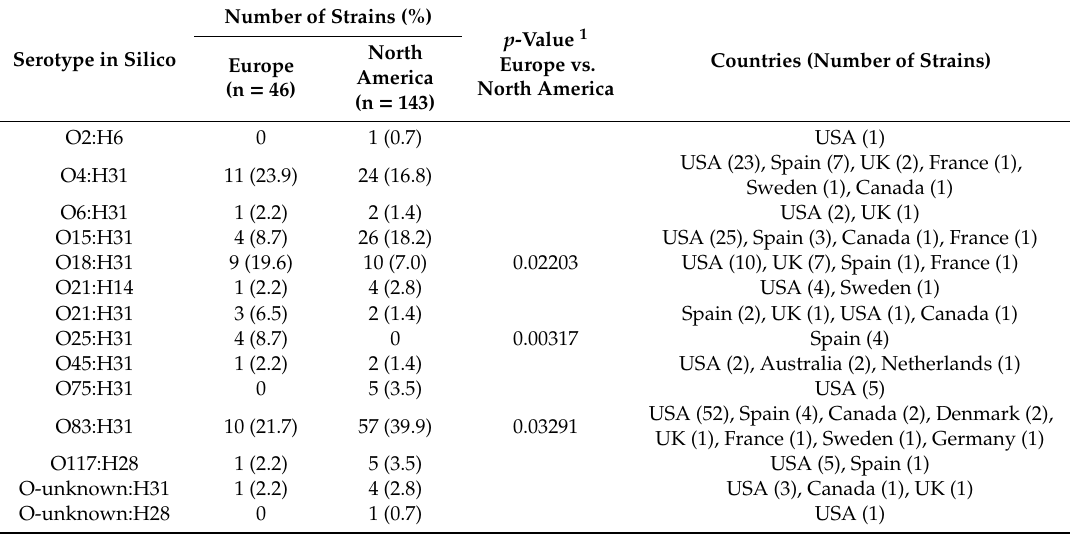
Table 9. Serotypes of the 197 ST372 strains according to